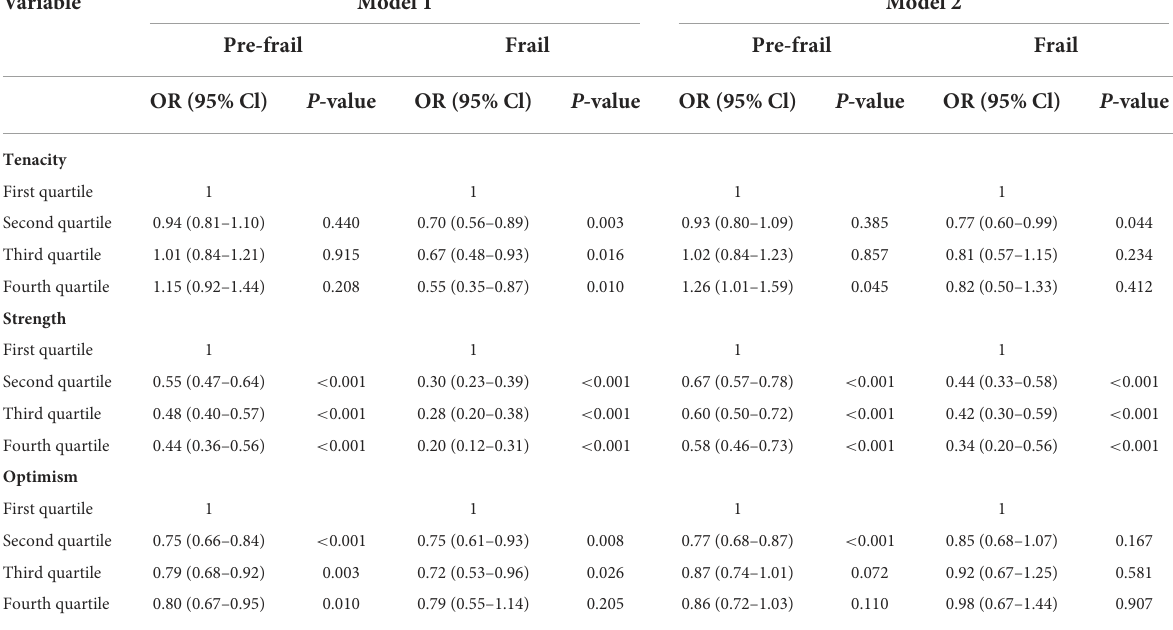
TABLE 3 Multinomial logistic regression analyses of risk factors associated with